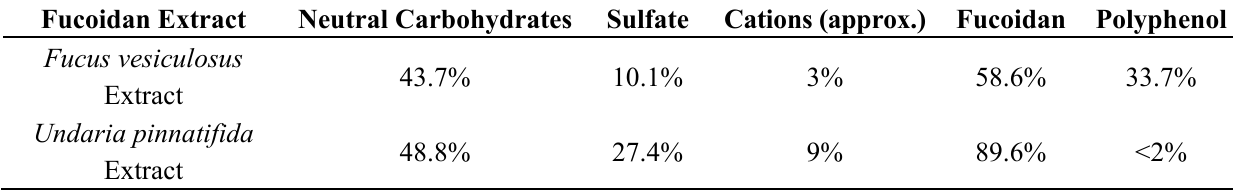
Table 1. Description of Fucus vesiculosus extract and Undaria pinnatifida